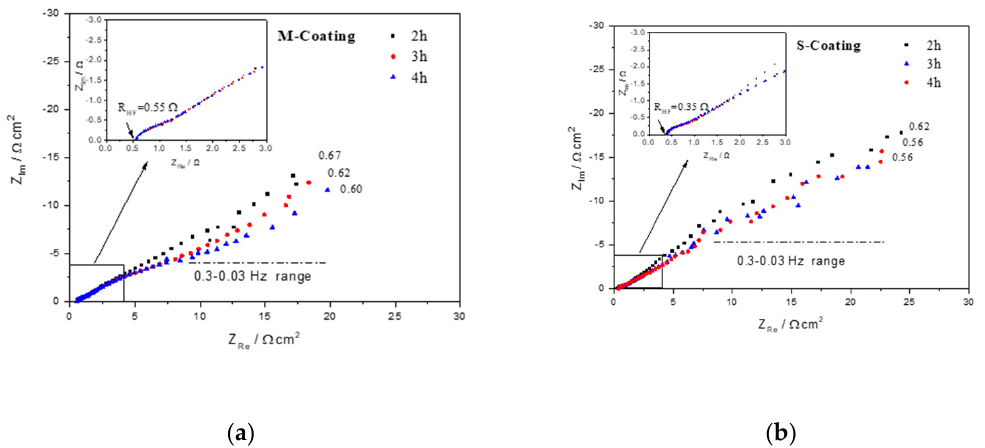
Figure 2. EIS spectra of M-coating ( a ) and S-coating ( b ) samples taken between 2 and 4 h of immersion during the slow thickening stage of the perovskite coating. The insets show the magnified view of the high-frequency portion of the spectra.